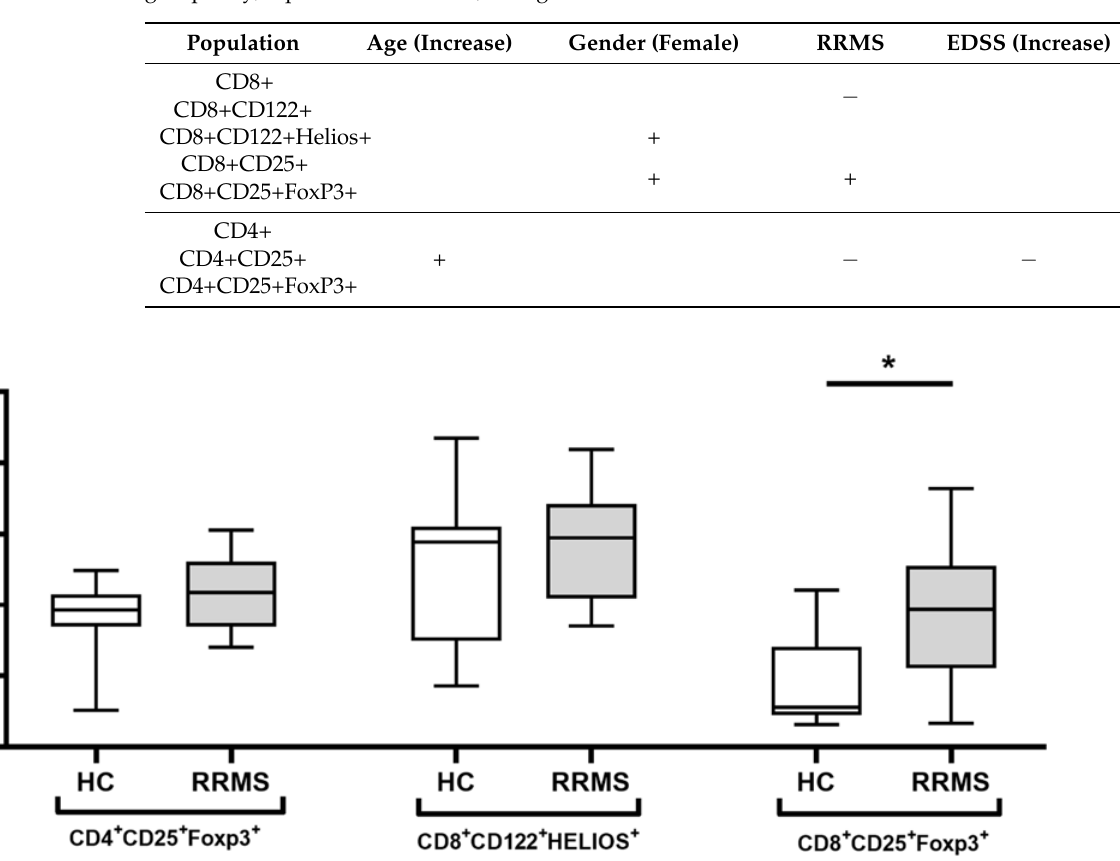
Figure 2. Frequency of CD4+ and CD8+ Treg populations. Comparison of the frequencies of CD4+CD25+FoxP3+ (among CD4+CD25+), CD8+CD25+FoxP3+ (among CD8+CD25+) and CD8+CD122+Helios+ (among CD8+CD122+) Treg populations in healthy controls (HC) and RRMS patients. * p ≤ 0.05.